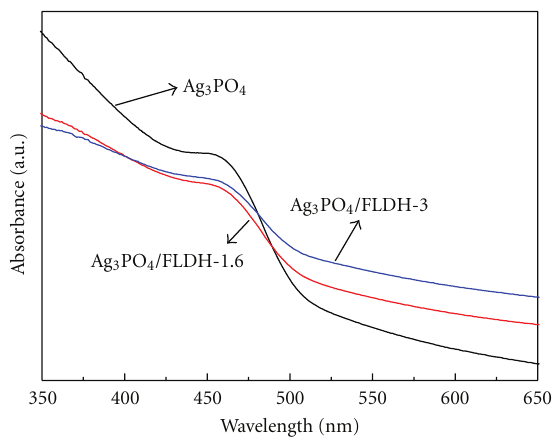
Figure 7: The adsorption capabilities of ARG on (a) Ag 3 PO 4 , (b) Ag 3 PO 4 /FLDH-1.6 and (c) Ag 3 PO 4 /FLDH-3 in the